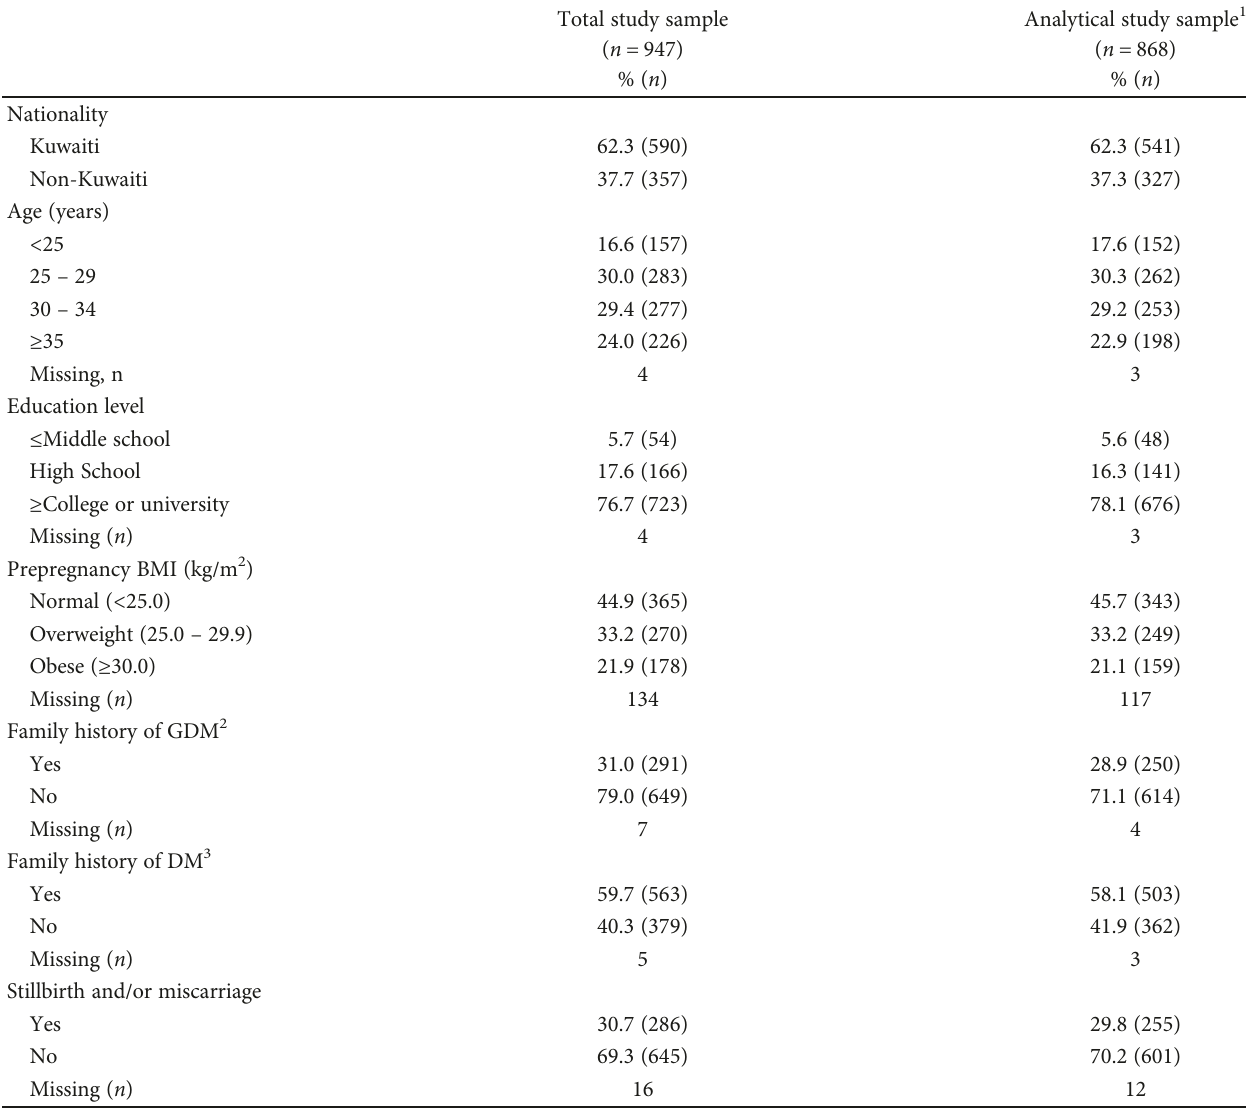
Table 1: Characteristics of the total study sample and the analytical